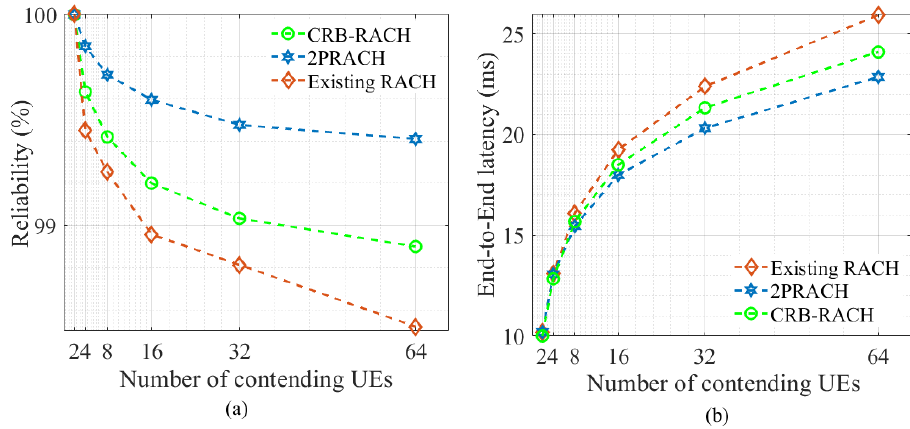
Figure 4. Performance comparison of process-based random access channel (2PRACH) with existing random access channel (RACH) and contention-resolution-based RACH (CRB-RACH) procedures with the varying number of contending UEs, where ( a ) network reliability (%), and ( b ) end-to-end latency